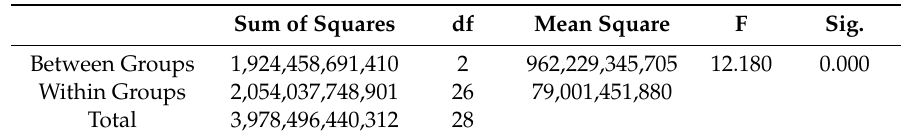
Table 3. One-way ANOVA (Y11).